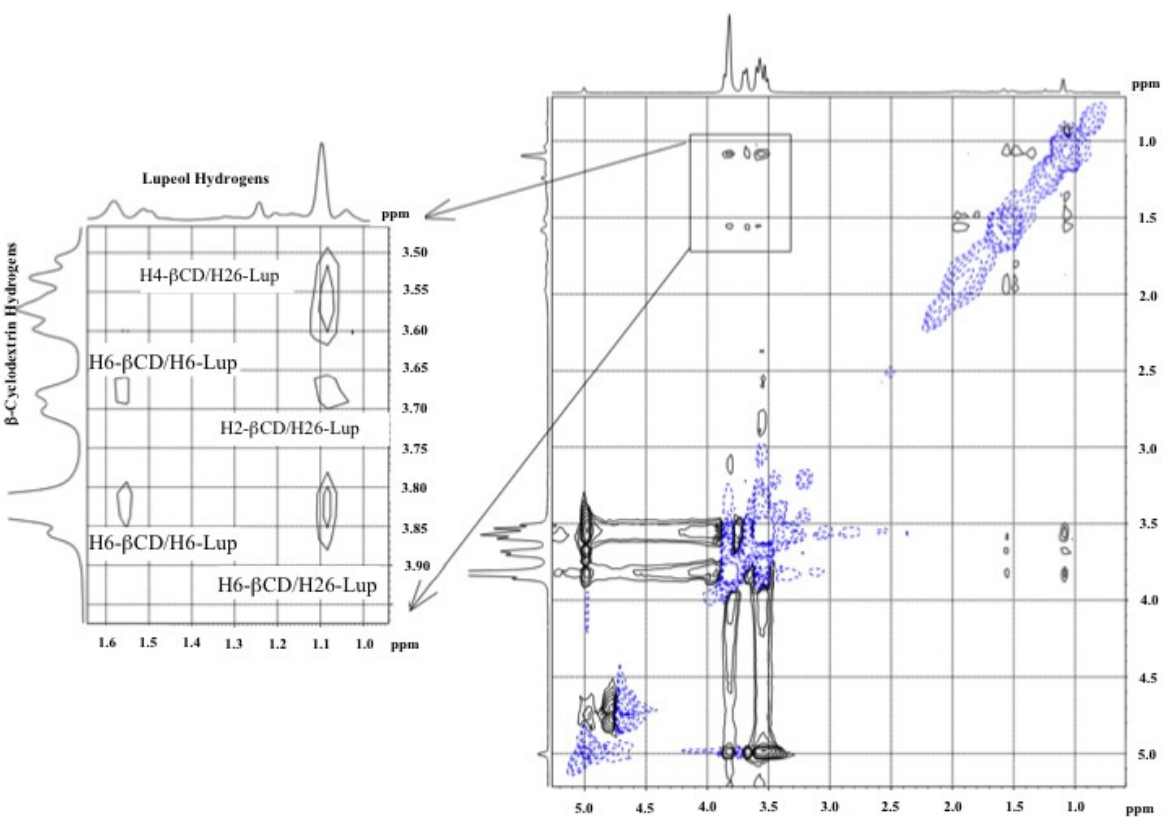
/D O (2:1)). For clarity, intermolecular NOE 6 2